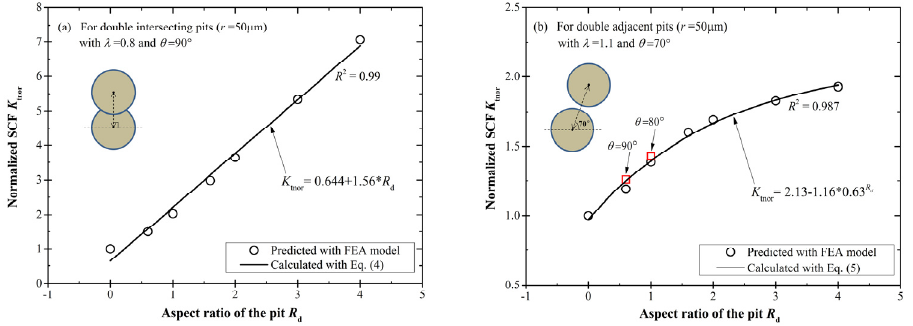
Figure 14. The relationship of the normalized SCF K tnor with the aspect ratio R d at the most disadvantageous configuration (i.e., the high stress concentration) of the relative position parameters. ( a ) For intersecting pits; and ( b ) for adjacent pits.